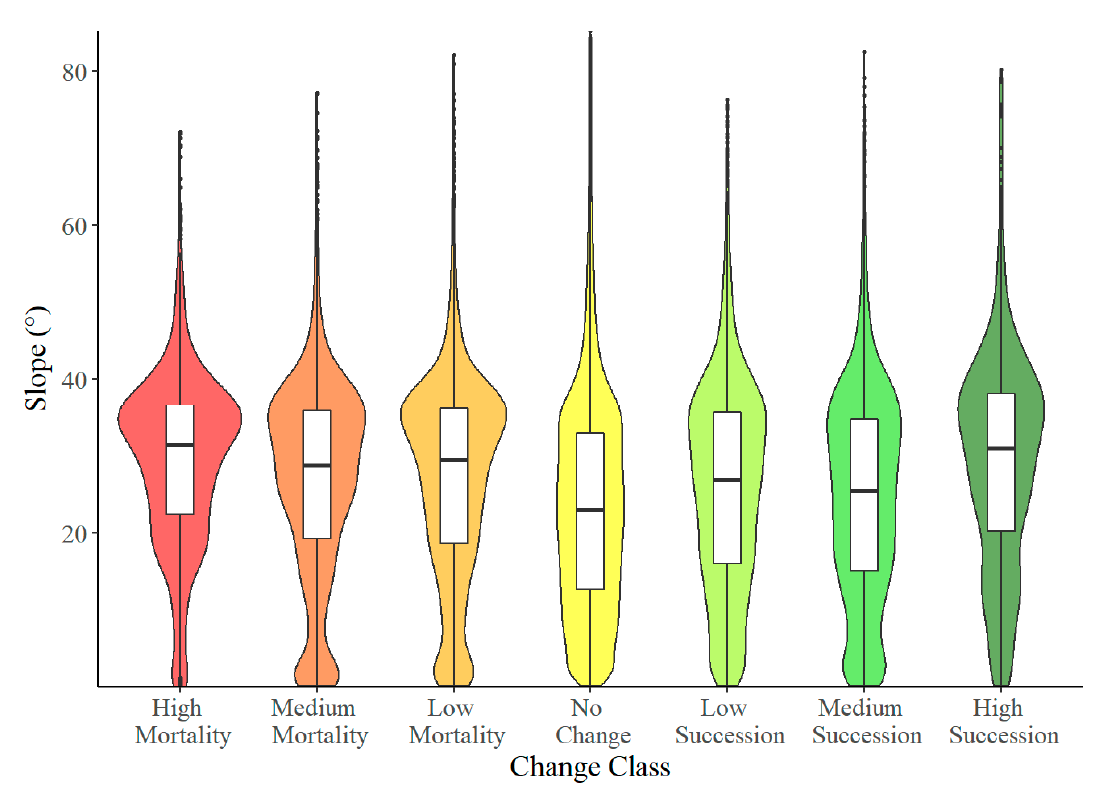
Figure 10. Distribution of slope within change class. The colored curves behind each box plot show a probability density function of the values in each distribution. Corresponding t-tests can be seen in Table 4. Table 4. Results of slope t-test between change classes. Significant values in bold. Significant differences were seen in 18 out of 21 tests.